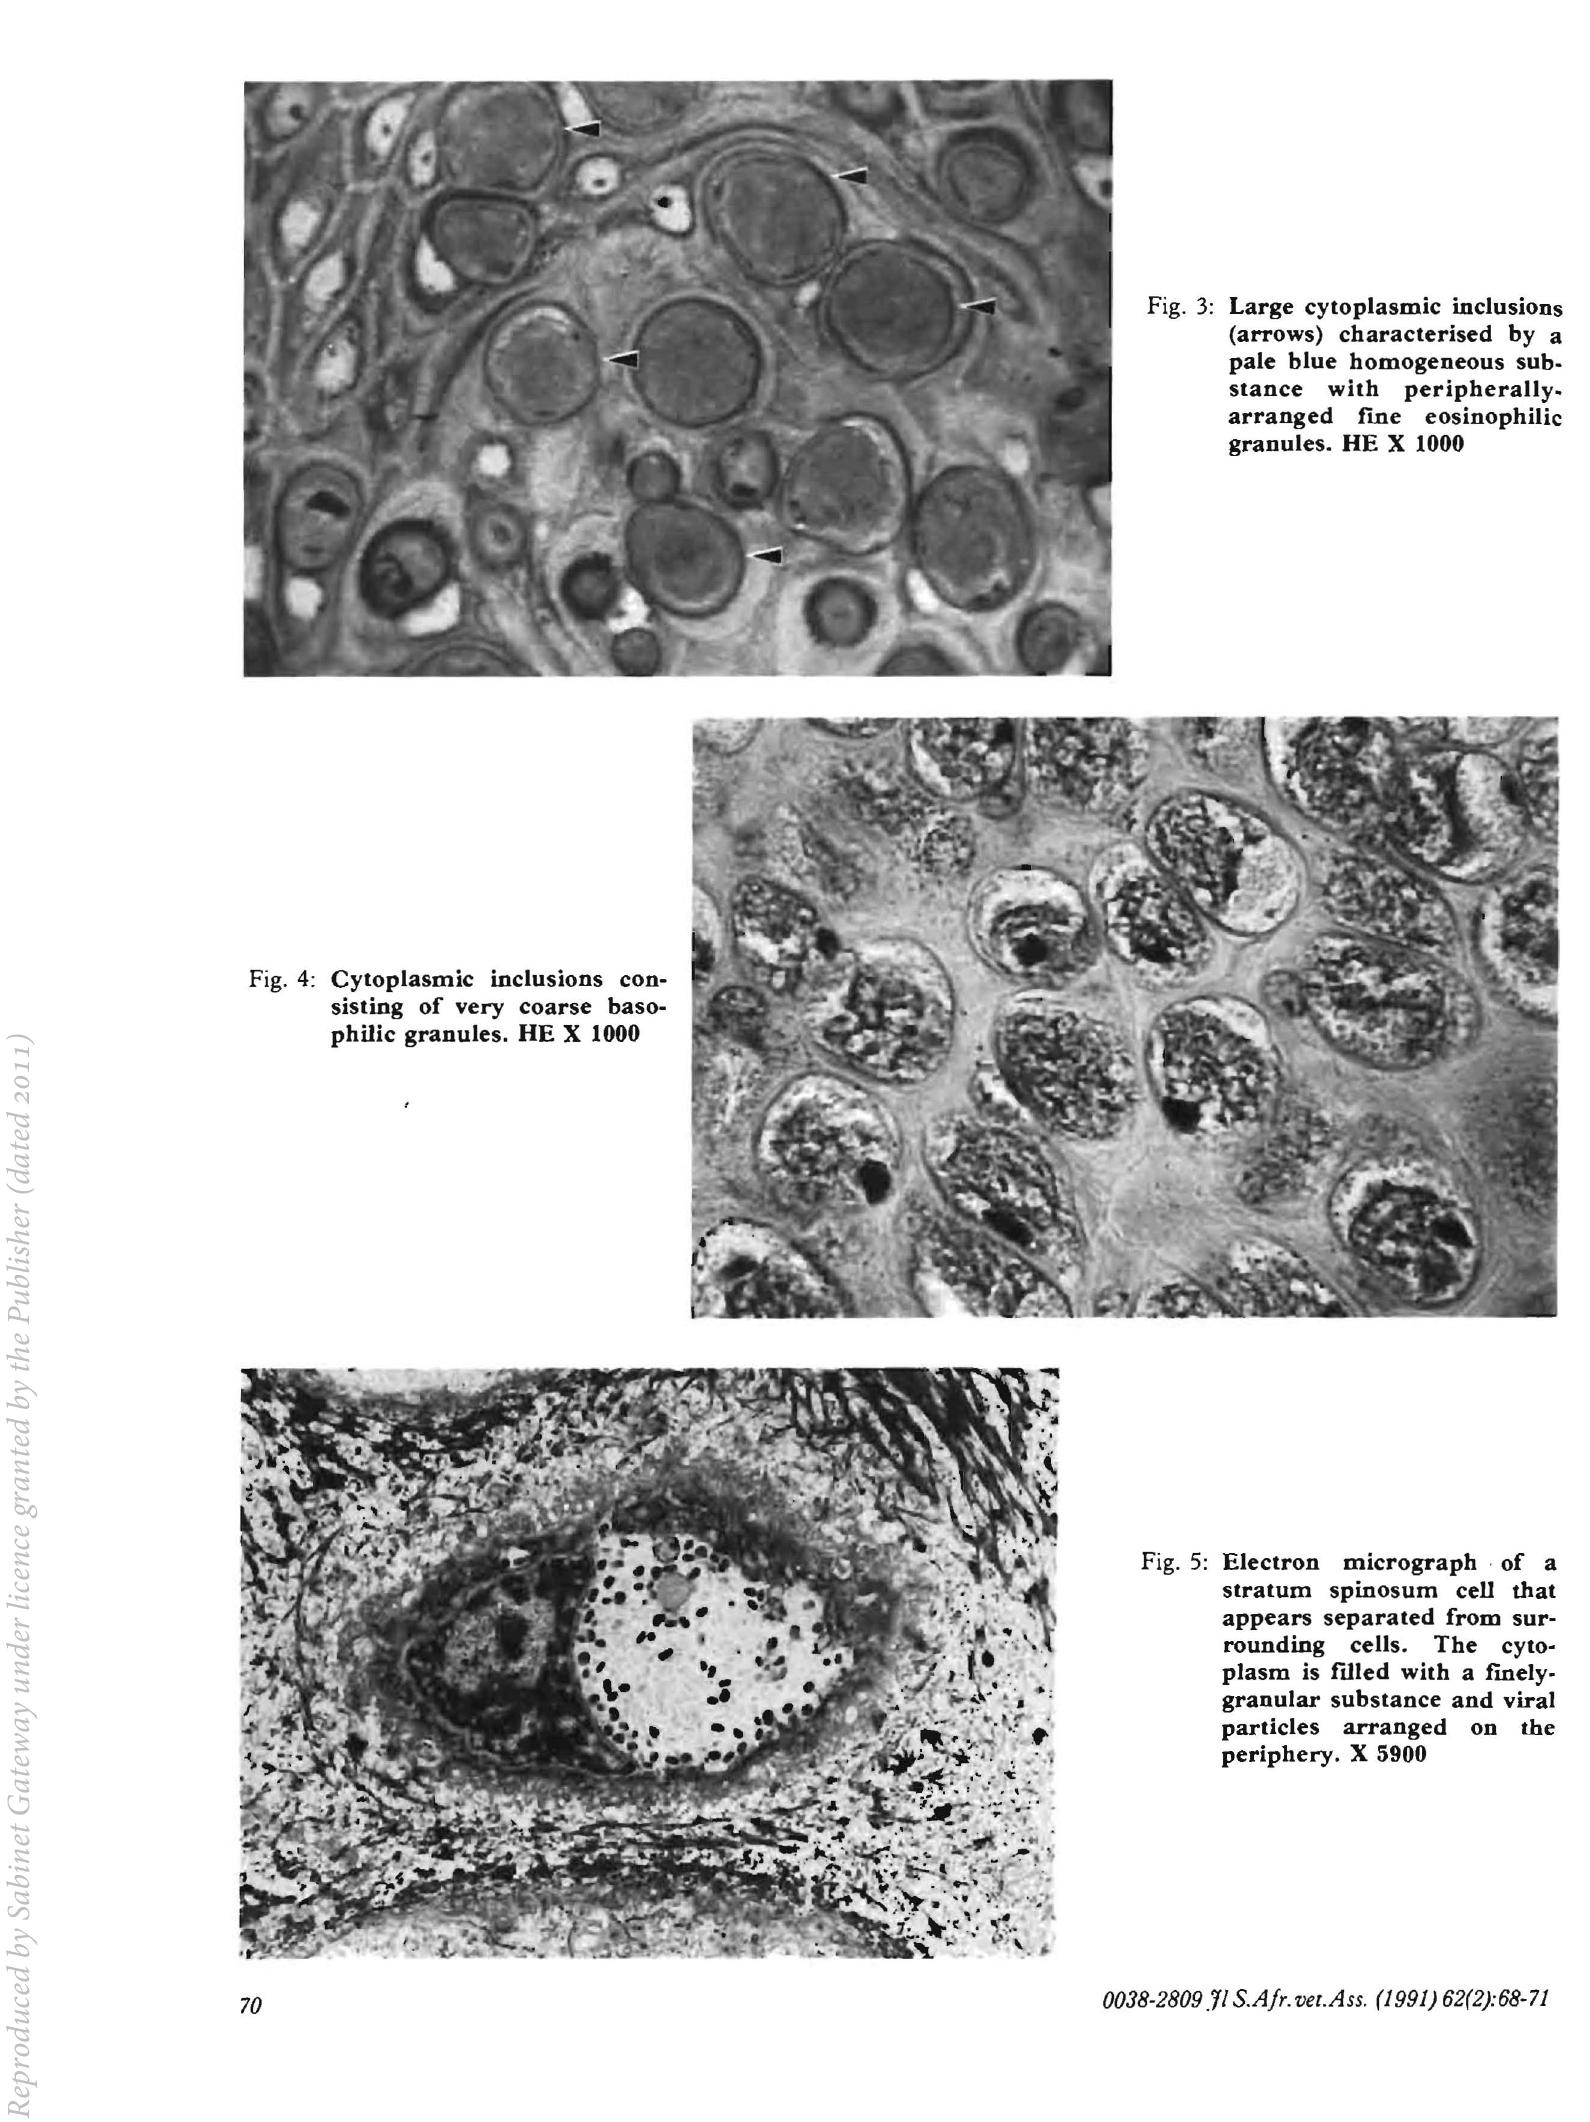
Fig. 5: Electron micrograph . of a stratum spinosum cell that appears separated from sur rounding cells. The cyto plasm is f"tJled with a tmely granular substance and viral particles arranged on the periphery. X